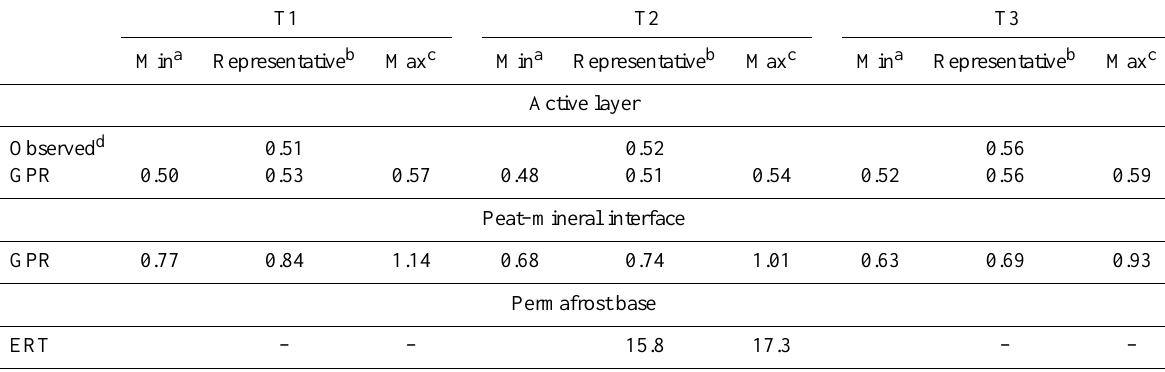
manual field measurement using a steel probe.